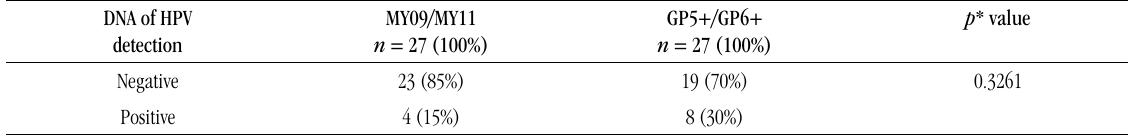
tABLE 3 – Percentage of DNA of HPV detection with oligonucleotide primers pairs